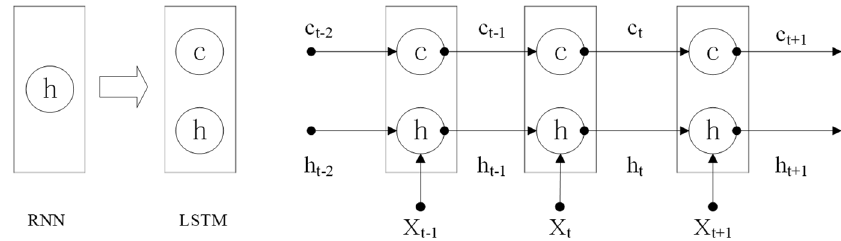
Figure 1. Expanded view of LSTM.